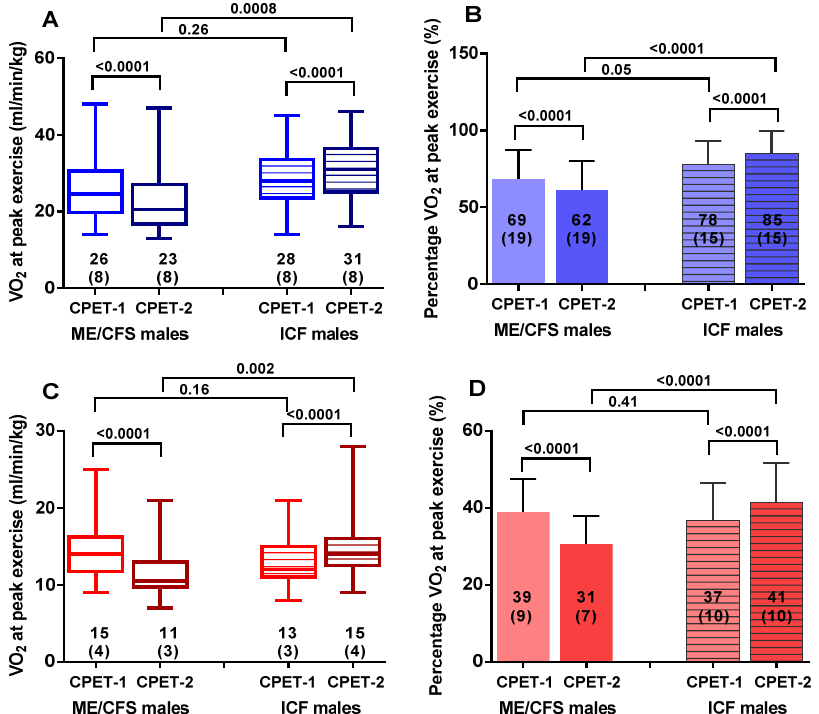
Figure 1. Peak exercise values and values at the ventilatory threshold for CPET-1 and CPET-2. Panel ( A ): peak oxygen consumption, panel ( B ): percent predicted peak oxygen consumption, panel ( C ): oxygen consumption at the ventilatory threshold, and panel ( D ): percent predicted oxygen consump- tion at the ventilatory threshold. Legend Figure 1: CPET: cardiopulmonary exercise test; VT: anaerobic or ventilatory threshold; VO 2 : oxygen consumption; ME/CFS: myalgic encephalomyelitis/chronic fatigue syndrome; ICF: idiopathic chronic fatigue.